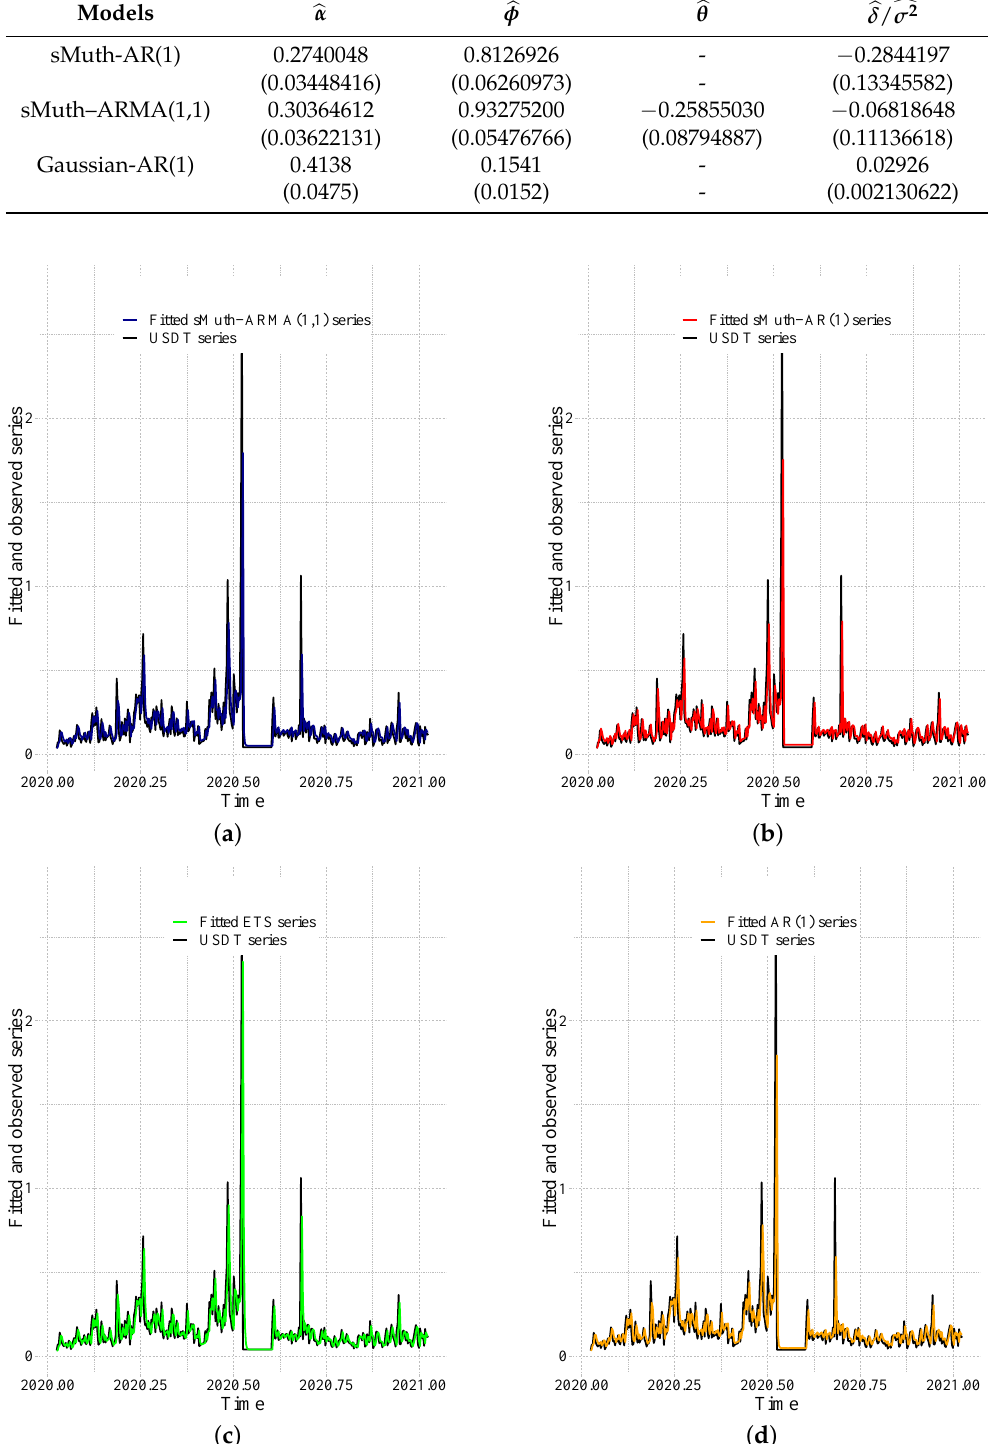
Table 4. The estimates and performance of models used in the current application.